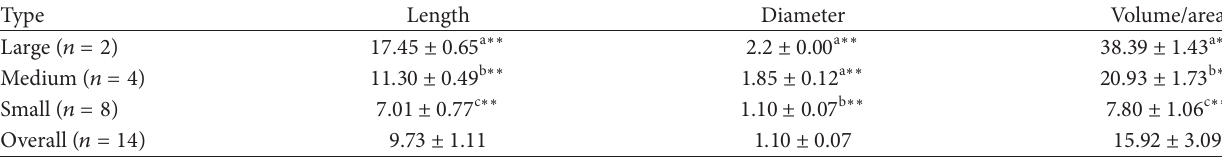
Table 2: Toxocara canis : host related effect between large, medium, and small types.